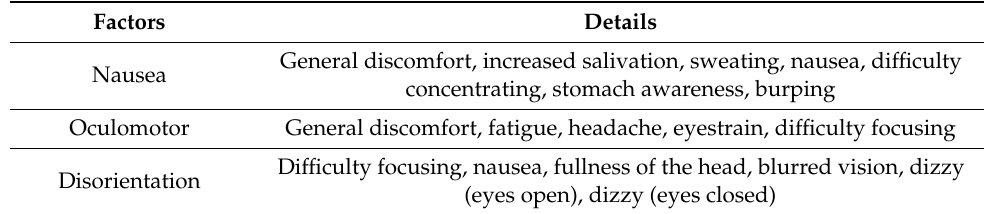
Table 1. Simulator Sickness Questionnaire (SSQ) factors. Factors Details General discomfort, increased salivation, sweating, nausea, difficulty Nausea concentrating, stomach awareness, burping Oculomotor General discomfort, fatigue, headache, eyestrain, difficulty focusing Difficulty focusing, nausea, fullness of the head, blurred vision, dizzy Disorientation (eyes open), dizzy (eyes